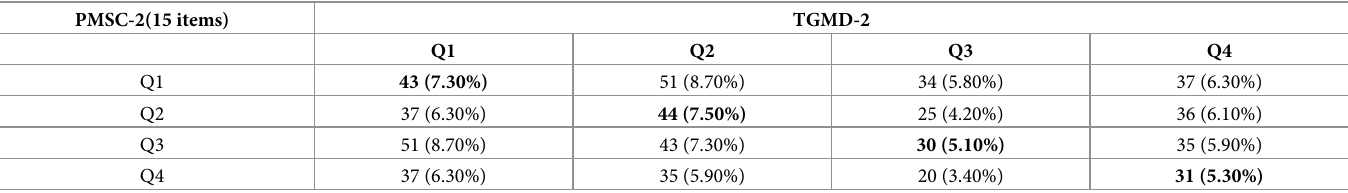
Table 4. Number (%) of participants in the whole sample ( N = 589) classified into quartiles (Q) based on total raw scores of the TGMD-2 and PMSC-2 (15-items). PMSC-2(15 items)